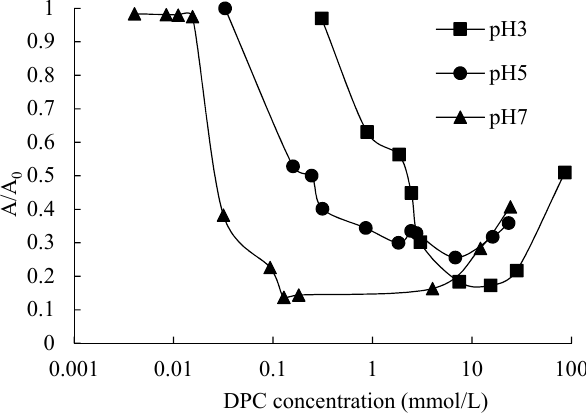
Figure 8. Silica particle stability with adsorption of DPC.